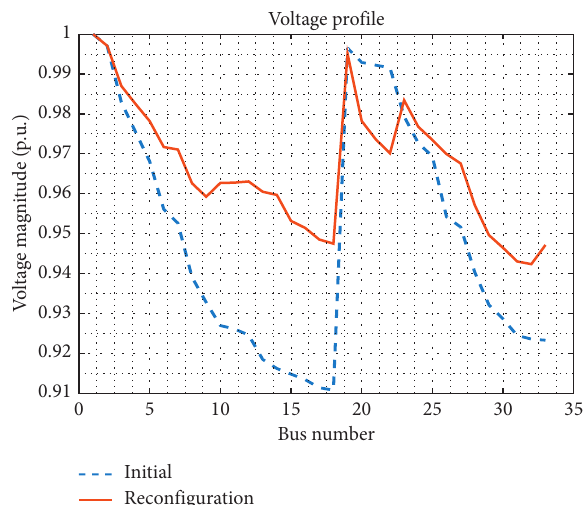
Figure 4: The voltage profile for the 33-bus system before and after reconfiguration.